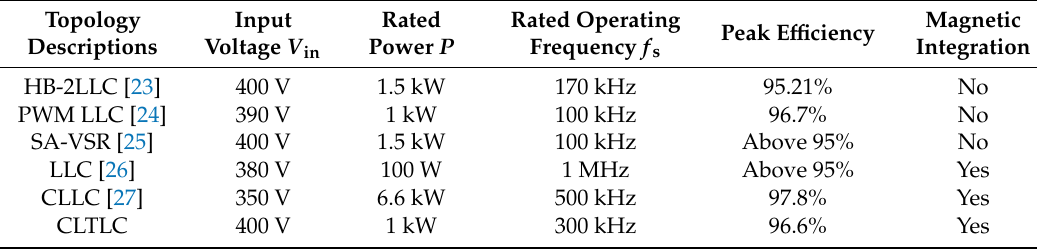
Table 3. Comparison of performances among di ff erent